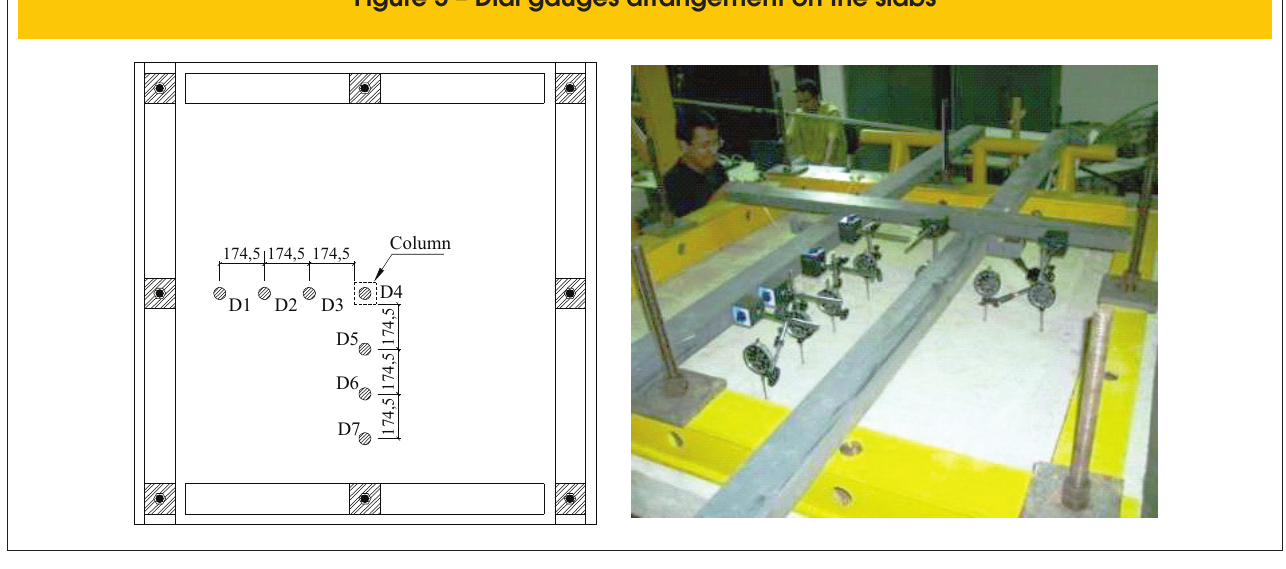
Figure 5 – Dial gauges arrangement on the slabs